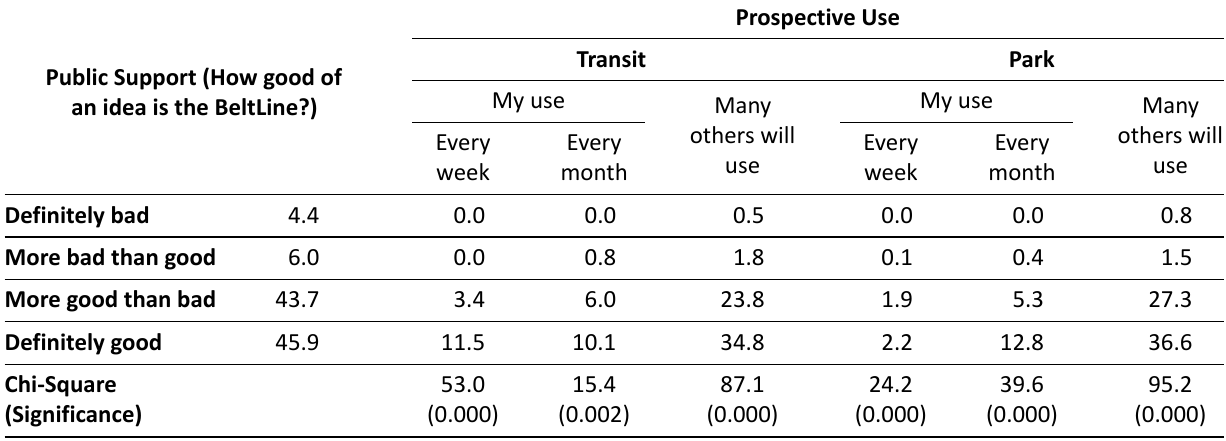
Table 4. Summary of public support and prospective use of the BeltLine (% of survey